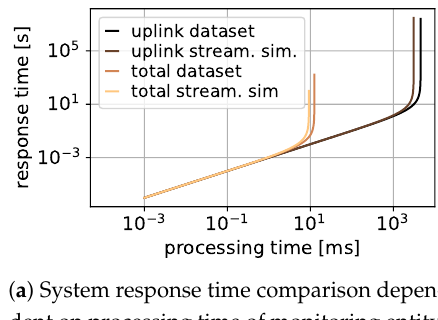
Figure 3. Modeling results